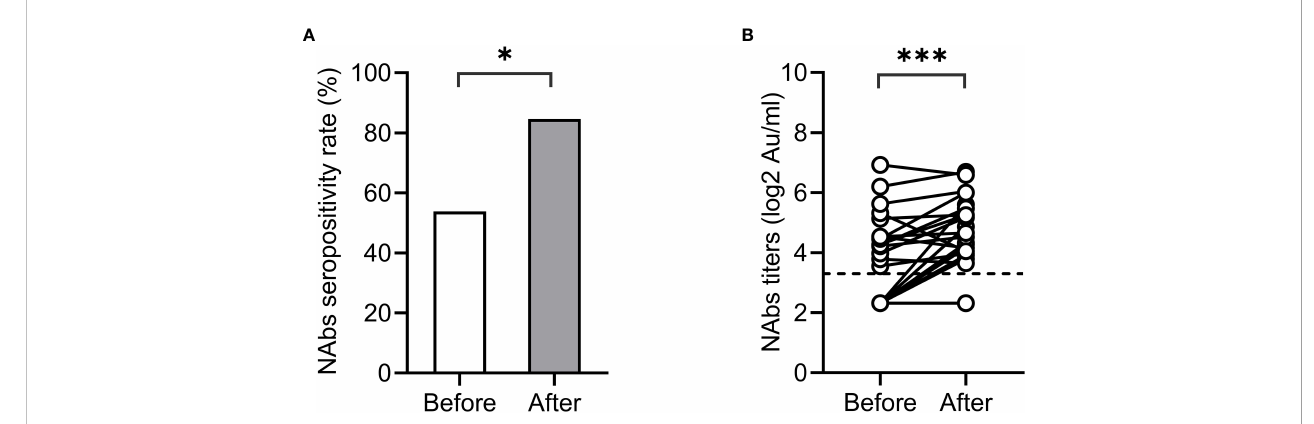
FIGURE 3 Impact of arti fi cial liver therapy on NAbs levels. NAbs seropositivity (A) and titers (B) before and after arti fi cial liver therapy in patients with liver